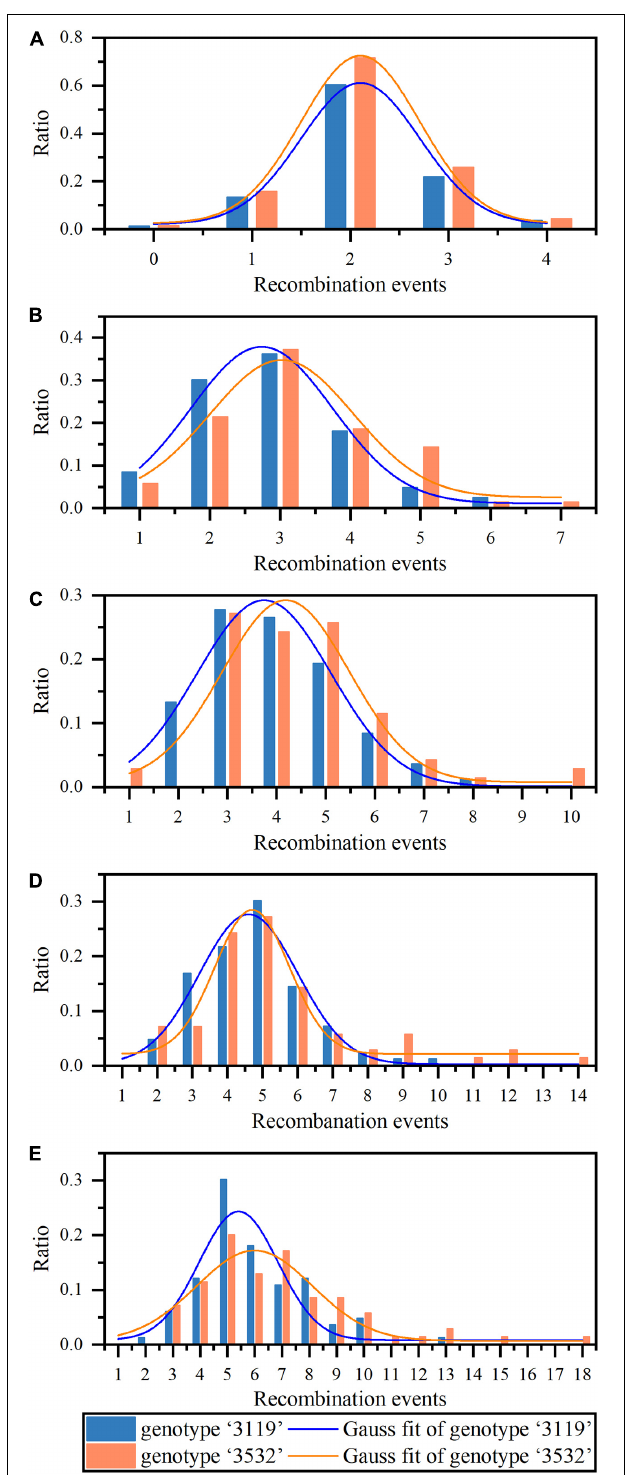
FIGURE 2 | The statistics and analysis of recombination events (REs) on Chr19 under different number of markers detected. (A–E) Represent the proportion of recombination events in the two triploid populations under 14, 24, 41, 60, and 79 markers detected, respectively. The two curves represent gaussian fitting of the frequency distribution (normal